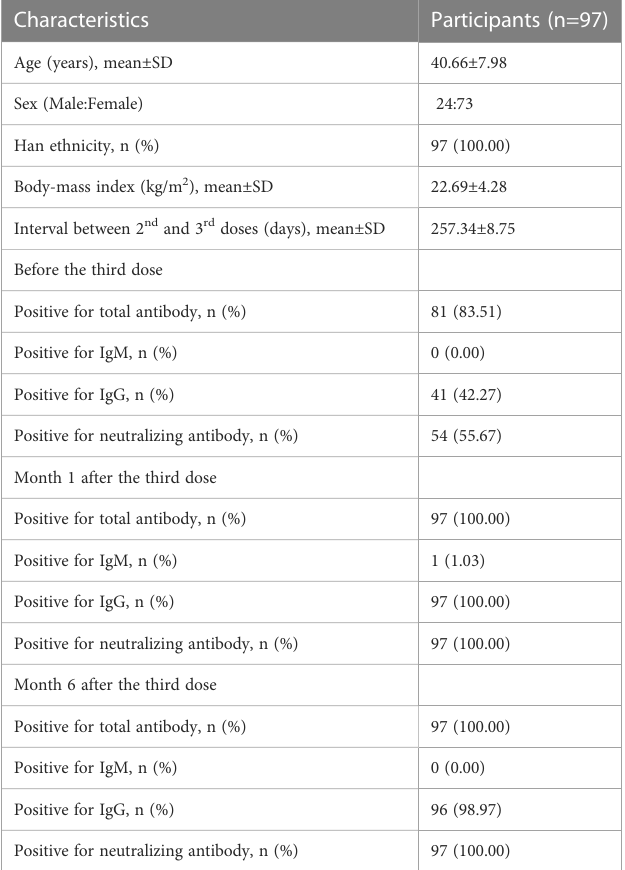
TABLE 1 Baseline characteristics and antibodies against SARS-CoV-2 in the participants.